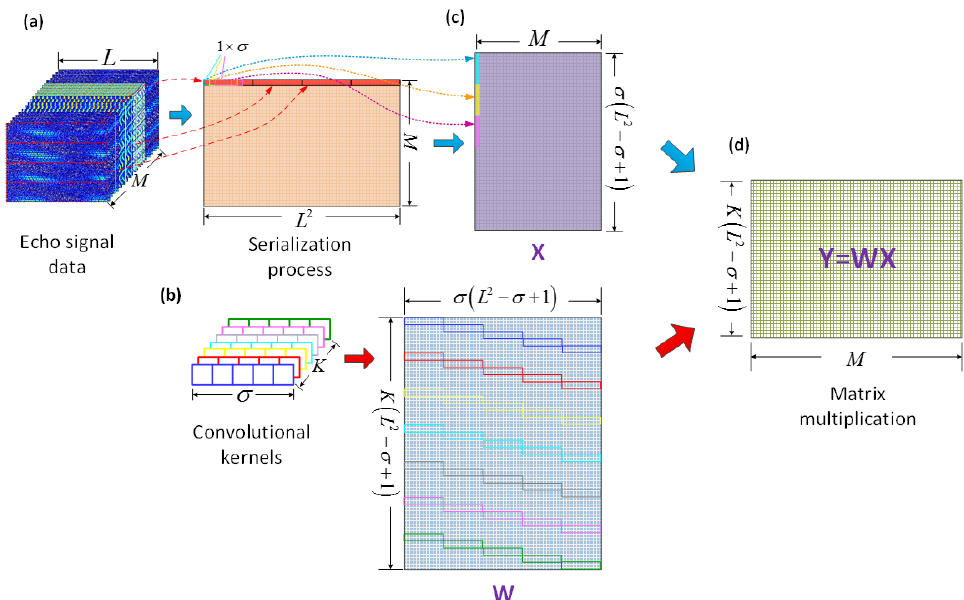
Figure 2. Standard procedure for generalized matrix multiplication of convolution layers. ( a ) Serialization process of echo signal data, ( b ) Expand convolutional kernels to form convolutional kernel matrix, ( c ) Form input matrix, ( d ) Obtain output matrix.